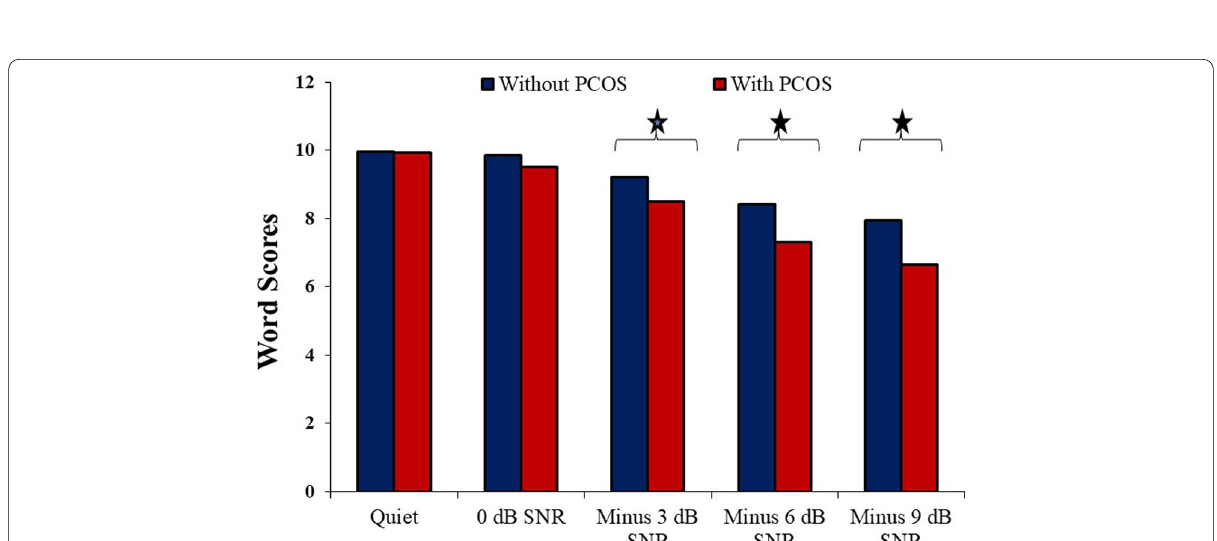
Fig. 2 Mean and standard deviation of the SPIN scores for words obtained from women with and without PCOS. Asterisk indicates the significant